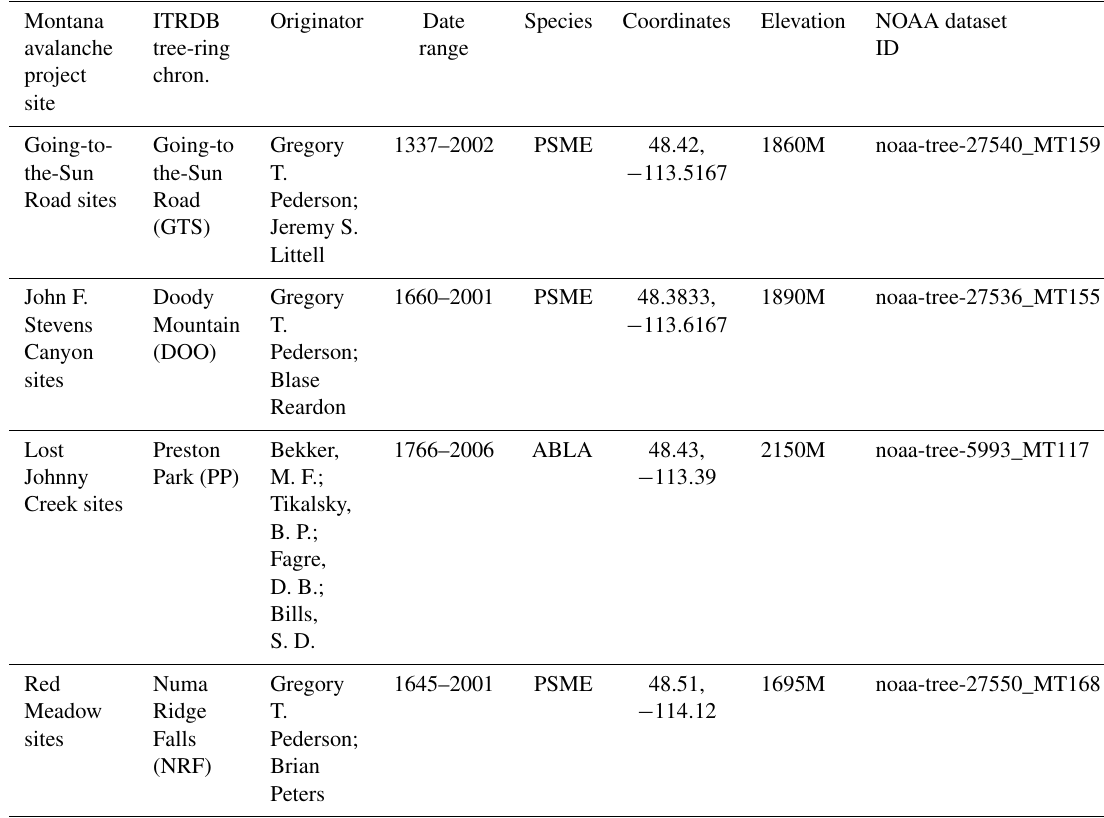
Table A2. Regional chronologies from the International Tree-Ring Database (ITRDB) used for cross dating. Montana ITRDB Originator Date Species Coordinates Elevation NOAA dataset avalanche tree-ring range ID project chron.